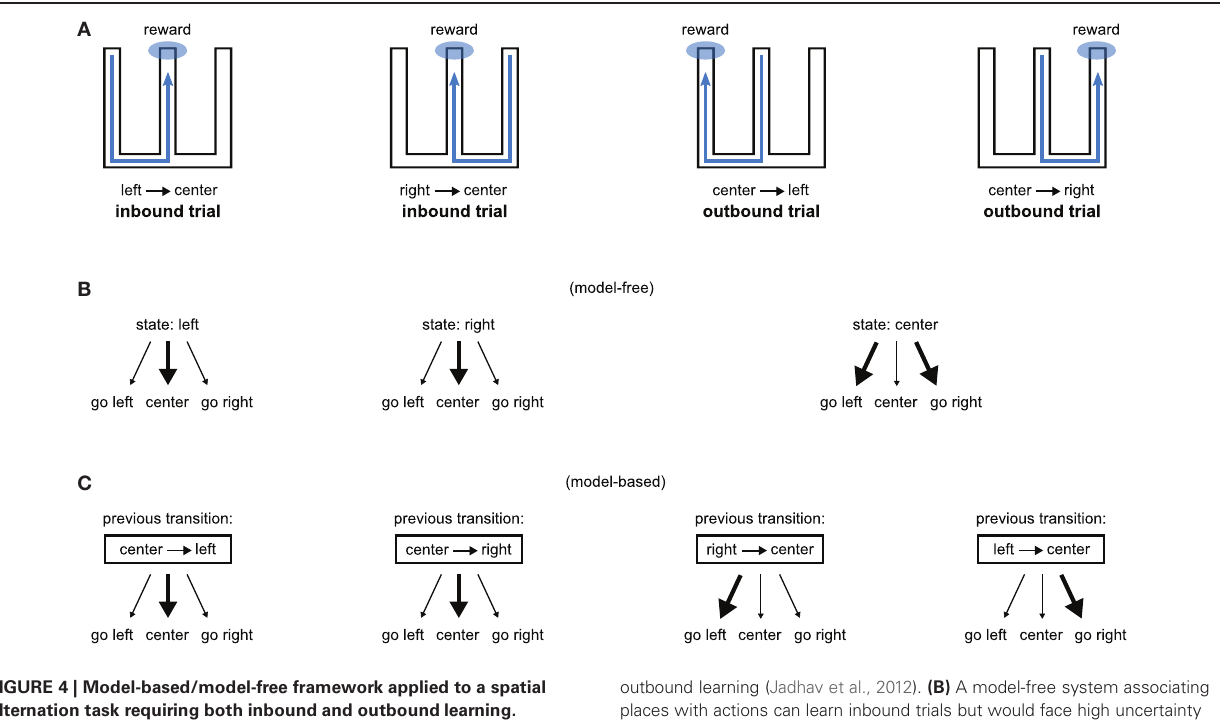
FIGURE 4 | Model-based/model-free framework applied to a spatial alternation task requiring both inbound and outbound learning. (A) W-shaped maze experienced by rats, adapted from Kim and Frank (2009). Hippocampal lesions impair both inbound and outbound learning (Kim and Frank, 2009) while disruption of awake hippocampal replay only impairs